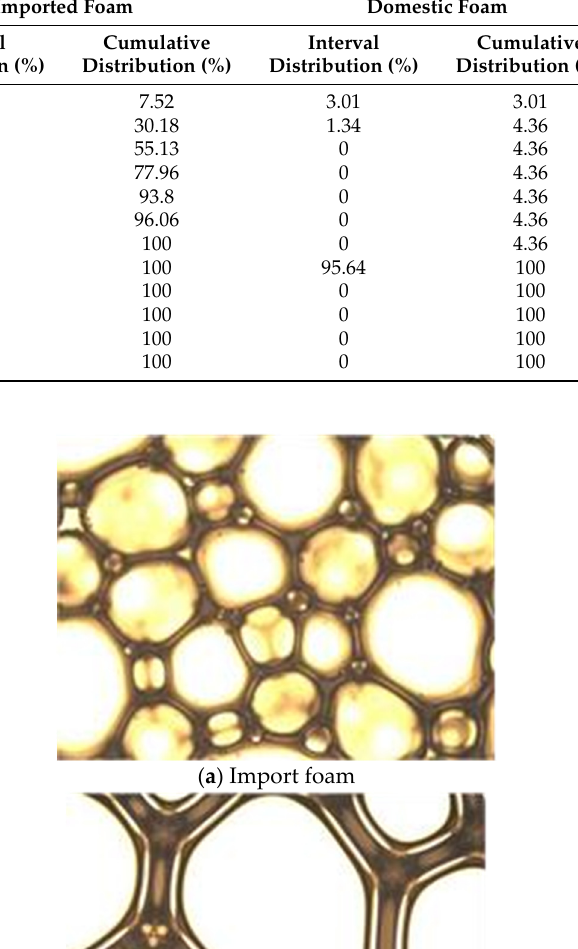
Table 6. Particle size distribution of three different foams.